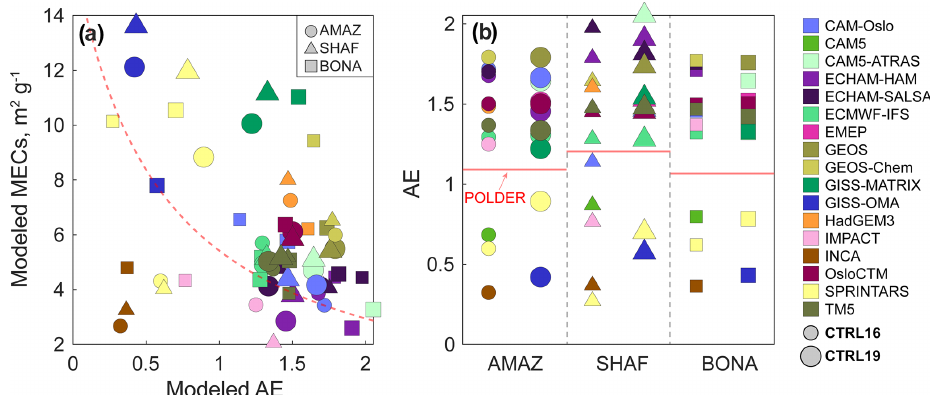
Figure 13. Dependence of modeled MECs on the AE (a) and the validation of the modeled AE against POLDER-GRASP data (b) . Data in (a) are model original output without collocation. The dashed line in (a) shows the relation calculated based on Mie-scattering theory and the ECHAM-HAM lookup table. Modeled AEs in (b) are collocated with POLDER-GRASP (shown as red lines) on a monthly basis during fire seasons. Table 3. The extinction enhancement factor (EEF) for BBA at 550nm wavelength from in situ measurements. Region Dry RH, % Reference RH, % EEF Reference Brazil 30 80 1.01–1.51 Kotchenruther and Hobbs (1998) Australia 20 80 1.1–1.7 Gras et al. (1999) Indonesia 20 80 1.2–2.1 Gras et al. (1999) Southern Africa 30 80 1 . 42 ± 0 . 05 (aged) India 40 Sheridan et al. (2002) China 30 80 1.64 Jung and Kim (2011) India ≤ 40 85 1 . 32 ± 0 . 14 Dumka et al.